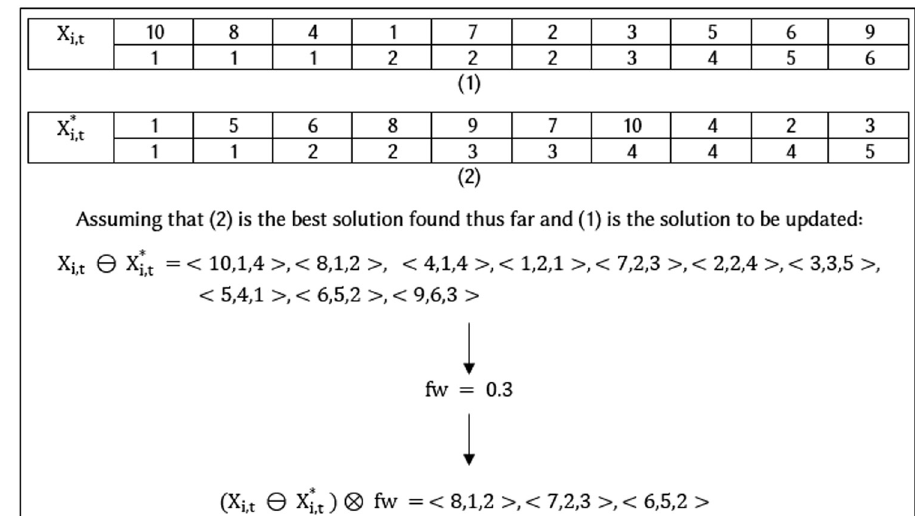
Figure 4: An example of using ( ⊖ ) ⊗ ∗ X X fw i t i t , ,